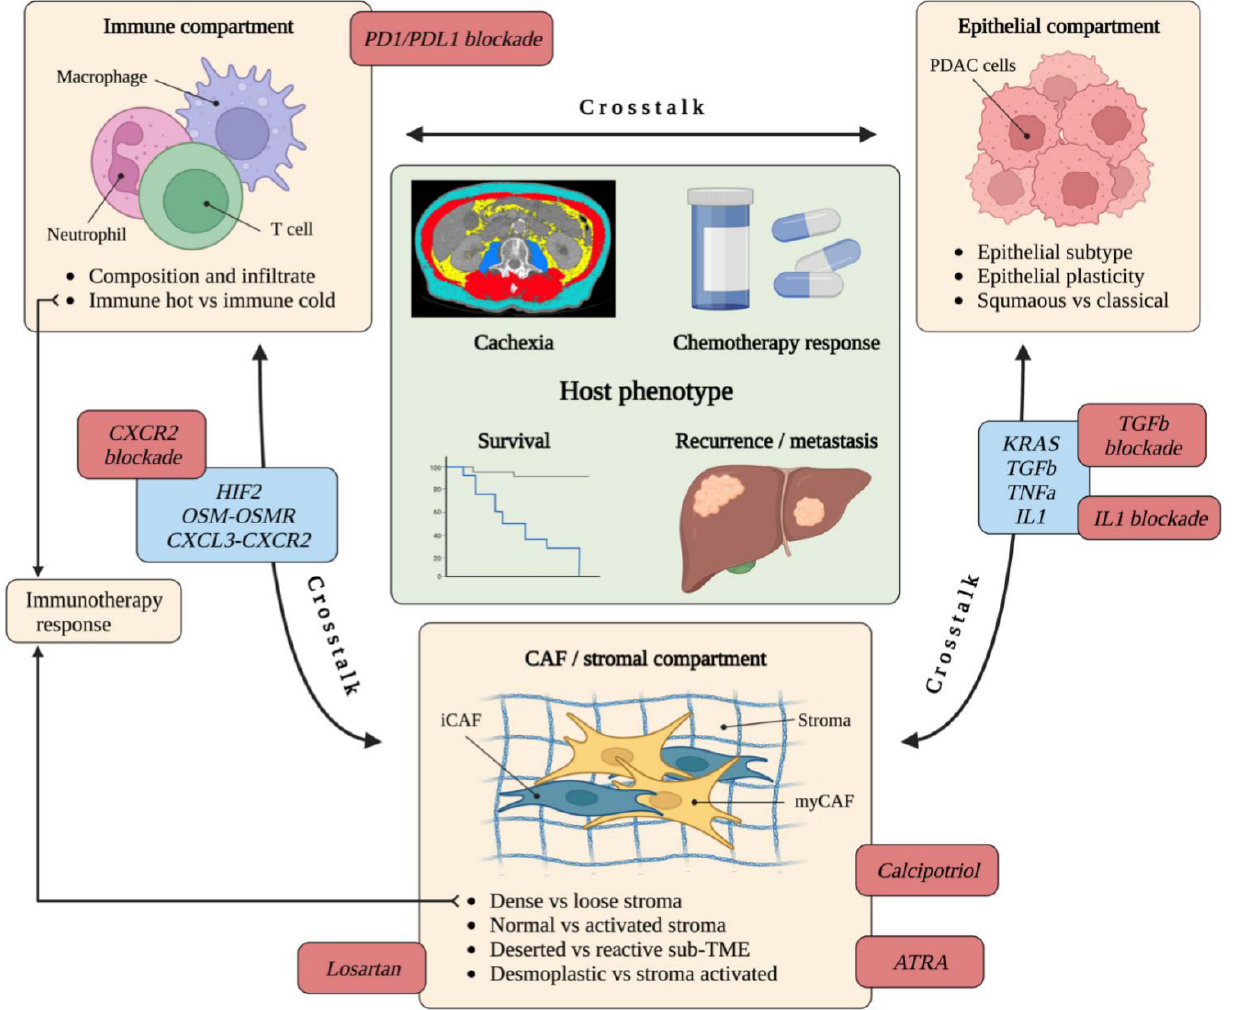
Figure 4. Tumour ‐ stroma crosstalk and CAF therapeutic targets. Crosstalk between the epithelial compartment, immune compartment and CAF compartment is shown along with the specific fea ‐ tures of each compartment which are influenced by this crosstalk (yellow boxes). Relevant signal ‐ ling networks (blue boxes) and potential therapeutic strategies (red boxes, discussed further in Sec ‐ tion 7) are also shown. Importantly, this crosstalk influences the host phenotype (green box)